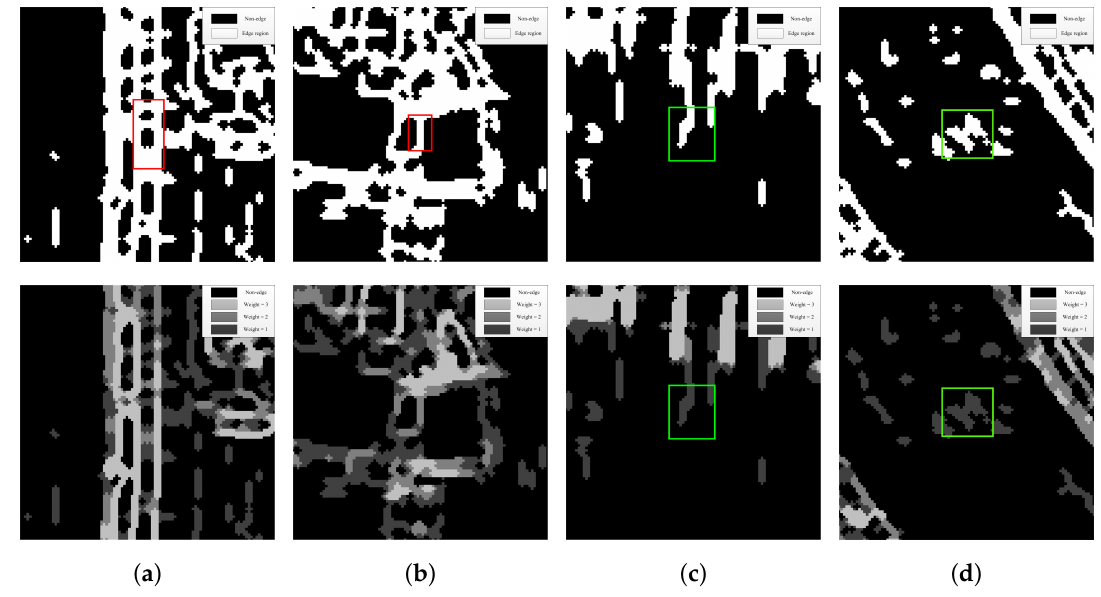
Figure 9. Edge detection results of typical ( a , b ) false alarms and ( c , d ) real targets. Images in the first row represent unweighted edge detection results and those in the second row represent gradient-weighted edge detection results. Different colors, as legend depicted, refer to different acutances of edge regions.